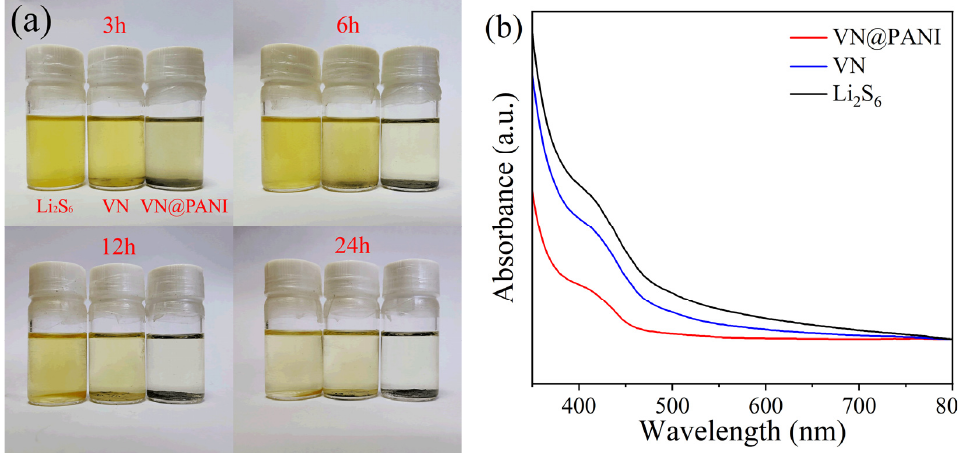
Figure 10. ( a ) Photograph of static adsorption test and ( b ) UV-visible spectra of Li 2 S 6 solution, Li 2 S 6 solution containing VN microrods and VN@PANI microrods.